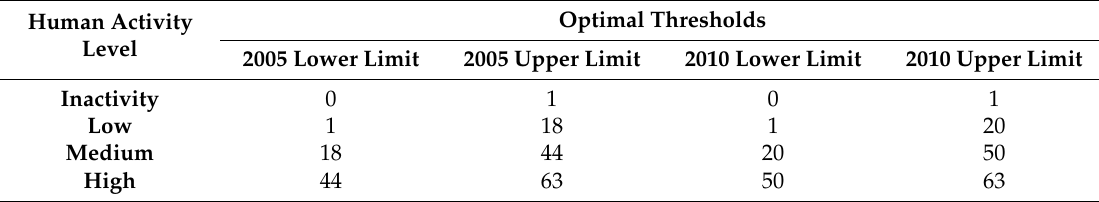
Table 3. Optimal thresholds of the human activity level in the study area for the years 2005 and